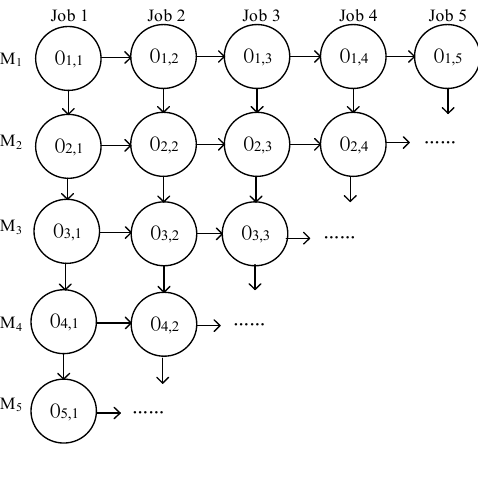
Fig. 3. Properties of a feasible